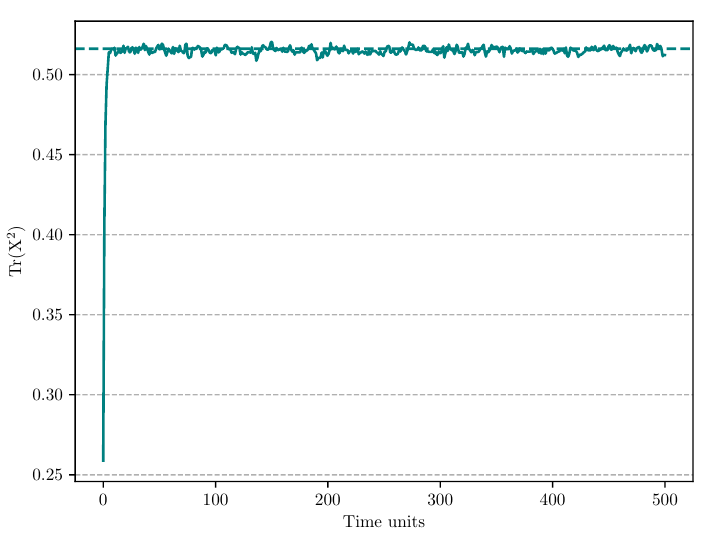
Figure 6: The computed value of Tr ( X 2 ) with MC methods for quartic potential one matrix model is consistent with that obtained using analytical saddle-point methods (shown by dashed lines). These results are with N = 300 and g = 1 and took about 40 minutes on a